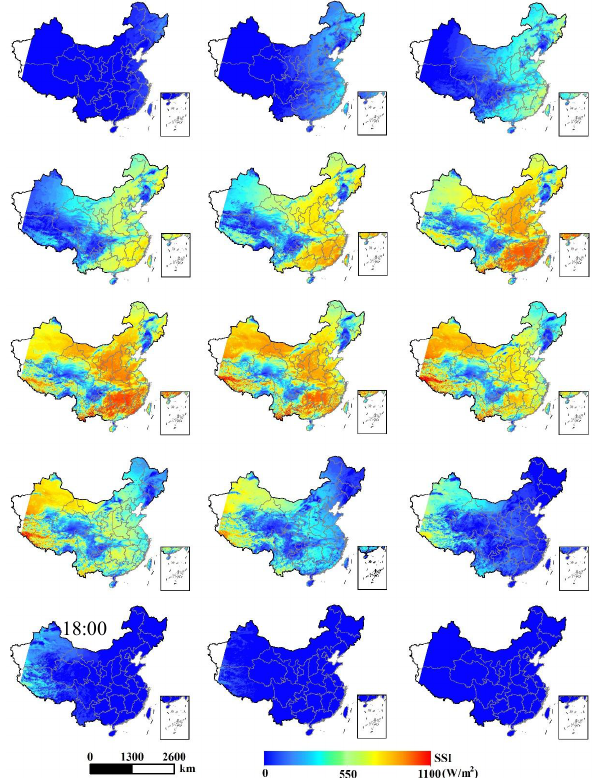
Figure 7 . Diurnal variability of the Himawari-8 hourly SSI from 06:00 to 20:00 in BJT on September 23,